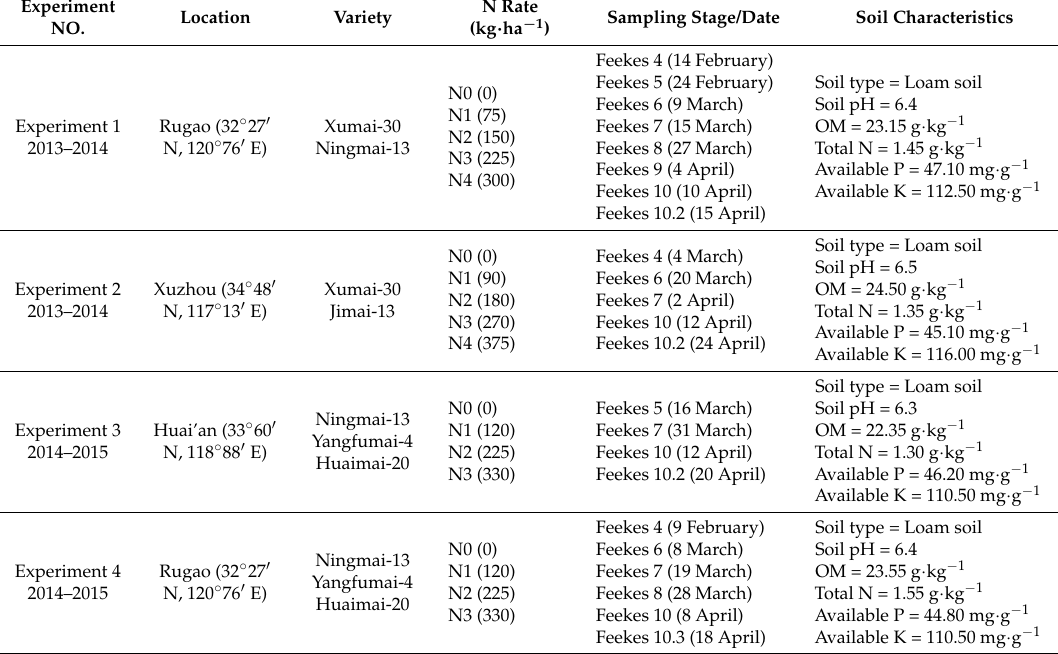
Figure 1. Study sites: wheat experiments conducted at Rugao, Xuzhou, and Huai’an Experimental Station in Jiangsu province of China. Table 1. Basic information about four field experiments.